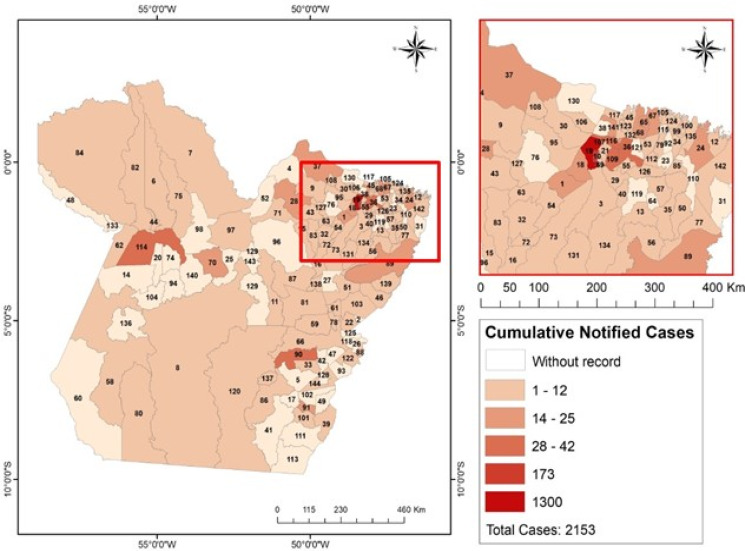
Propagation of new cases of COVID-19 accumulated in the municipalities of the state of Pará in the sixth week after registration of the first case in the region.